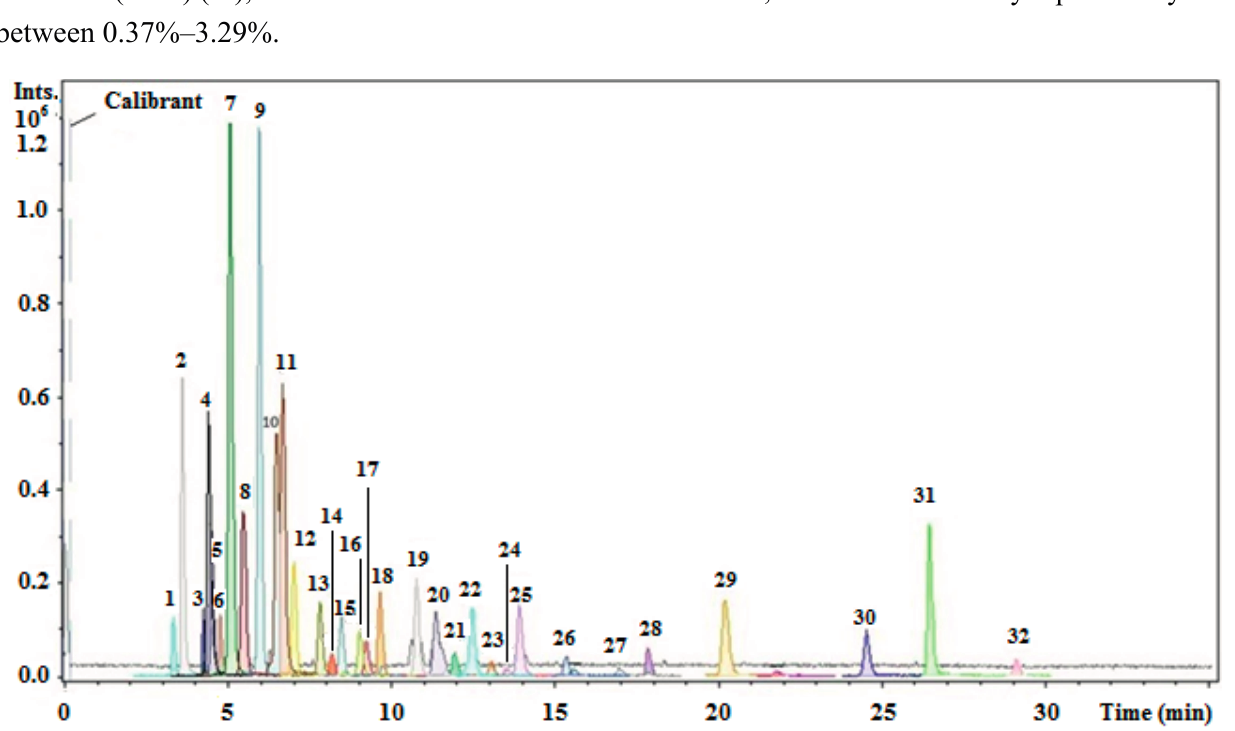
Figure 1. Base peak chromatogram of PEHS extract; peaks are identified with numbers according to the elution